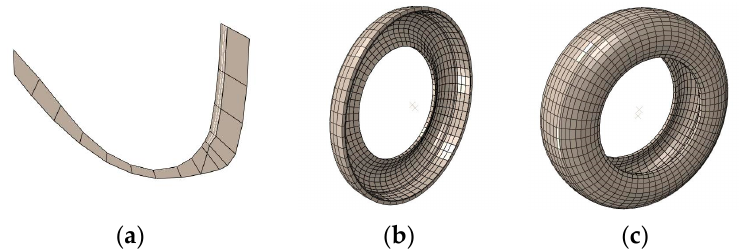
Figure 4. Tire modeling: ( a ) 2D half-section tire model; ( b ) partial tire model; and ( c ) complete tire model. tire